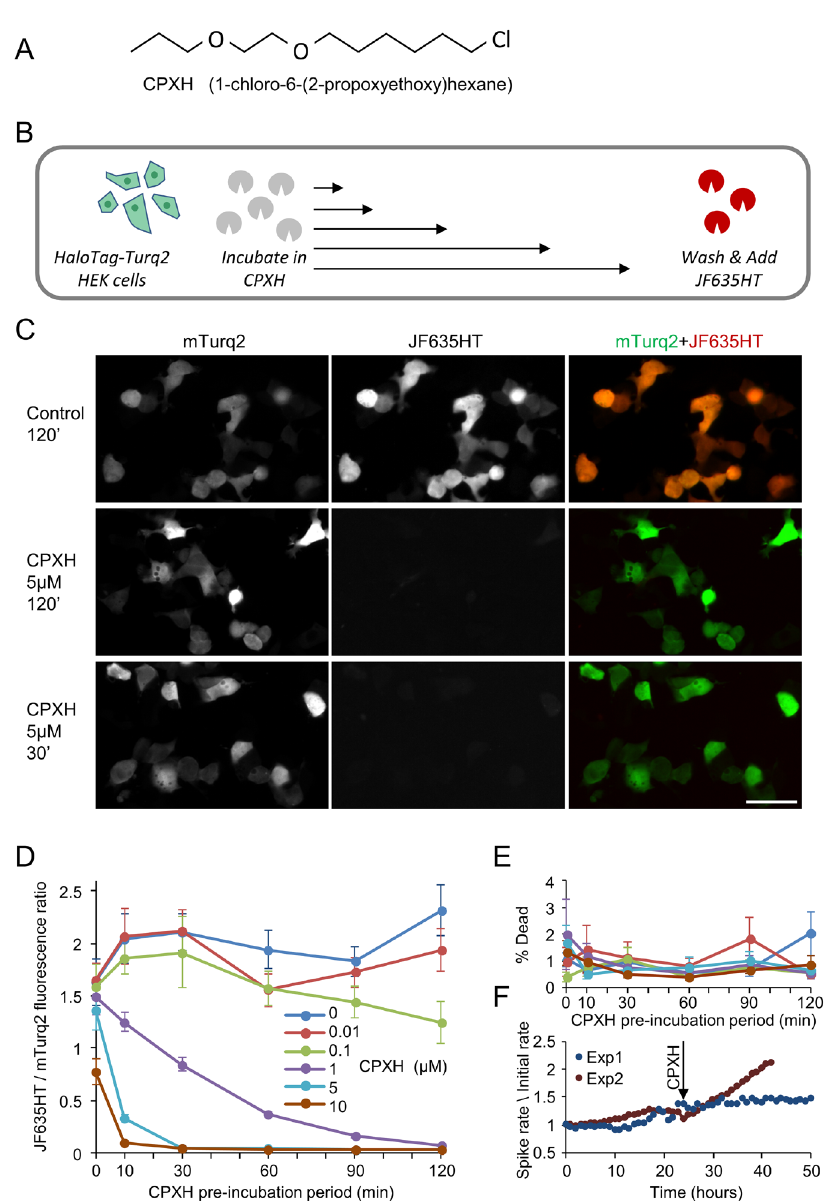
Figure 2. Blocking efficacy of CPXH. ( A ) Chemical structure of CPXH {1-chloro-6-(2-propoxyethoxy)hexane}, the non-fluorescent, cell-permeable HaloTag blocker tested in this study. ( B ) Testing CPXH blocking efficacy. HaloTag-mTurq2 was expressed in HEK293 cells growing in 96 well plates. The cells were treated with 0.01, 0.1 ,1 ,5, or 10 µM CPXH, or carrier solution (0.1% DMSO in cell culture media), for 10, 30, 60, 90, or 120 minutes (all combinations of concentration and duration). The cells were washed with cell culture media and labeled with JF635HT (100nM for 30 minutes). The cells were then washed with HBSS and imaged. Imaging was carried out on an automated high-content imaging system, providing reads from >10,000 cells per concentration and time point per experiment (2 separate experiments). Note that cells at t=0 were treated with CPXH and washed immediately, and were thus exposed to the blocker for anywhere between a few seconds and a minute. ( C ) Representative images of JF635HT labeling in mTurq2-positive HEK293 cells. Cells were exposed to CPXH (or carrier solution) at indicated concentrations and durations. Bar, 50µm. ( D ) JF635HT / mTurq2 (background-corrected) fluorescence ratios at the CPXH concentrations and incubation times tested. Only fields of view with at least 90 mTurq2 positive cells were included (8 to 16 fields of view per condition, two separate experiments). Systematic increases in blocking efficacy were observed with increases in CPXH concentrations and pre-incubation durations. Slight increases in JF635HT / mTurq2 ratios were also observed following pre-incubation with carrier solution or low CPXH concentrations, which might relate to the presence of DMSO in the carrier solution. ( E ) Live/ Dead assays (using Propidium Iodide / NucBlue Live, HEK293 cells, and high-content imaging as in C , D ) point to negligible cell death at all tested CPXH concentrations and treatment durations with no dependence on concentration or duration. ( F ) CPXH (10 µM) did not suppress spontaneous network activity (a sensitive measure of neuronal viability) in networks of rat cortical neurons growing on multielectrode arrays. CPXH was added after 24 hours of baseline recordings, and activity was followed for additional 18 or 47 hours (two experiments). Spike rates (action potentials recorded from all electrodes per minute; one-hour averages) were normalized to spike rates during the first hour (1,546 and 7,663 spikes/min, respectively). Error bars ( D, E ) indicate SEM of fields of